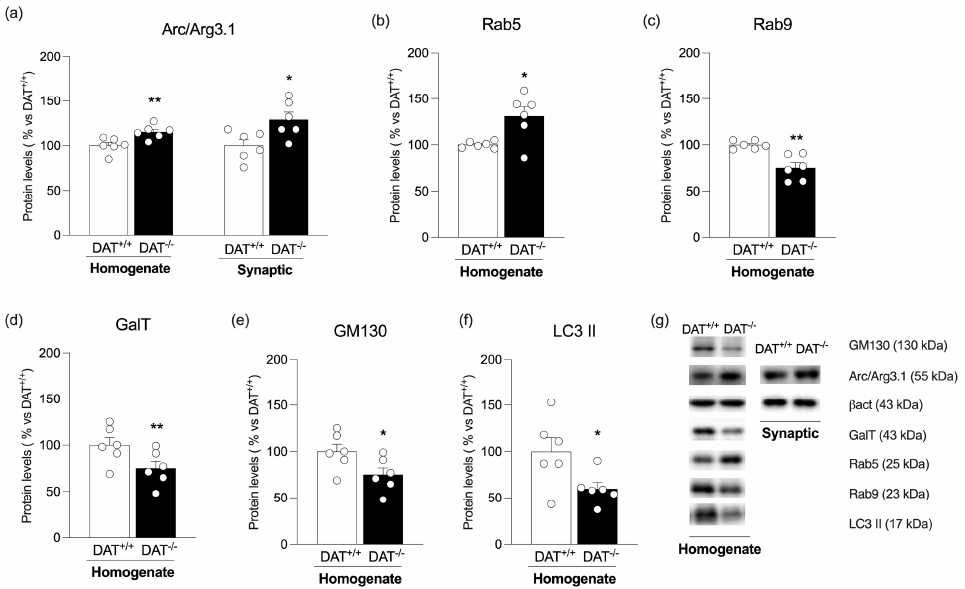
endosome-to-trans-Golgi-network trafficking [45]. DAT deletion significantly increased Rab5 proteins level (Figure 4b: +31% vs DAT +/+ , t = 2.931, p = 0.0150), while, in contrast, it reduced Rab9 expression (Figure 4c: − 25% vs DAT +/+ , t = 4.331, p = 0.0015) in the whole homogenate. Next, the trans-Golgi and cis-Golgi markers, GalT and GM130, respectively [46], were reduced in the homogenate of DAT − / − rats (Figure 4d: − 25% vs DAT +/+ , t = 2.232, p = 0.0497; Figure 4e: − 37% vs DAT +/+ , t = 3.435, p = 0.0064). We also measured a well-known autophagy marker, the active form of the light chain protein 3, LC3-II [47], which was vs. DAT +/+ , t = 4.965, p = 0.0006). To the contrary, CRMP-2 (Figure 5b: − 19% vs. DAT +/+ , significantly decreased in the homogenate of DAT − / − animals (Figure 4f: − 40% vs DAT +/+ , t t = 2.713, p = 0.0218), nCad (Figure 5c: − 24% vs. DAT +/+ , t = 2.456, p = 0.0339), and = 2.430, p = 0.0354). Neuroligin-1 (Figure 5d: − 21% vs. DAT +/+ , t = 3.471, p = 0.0060) levels were decreased.